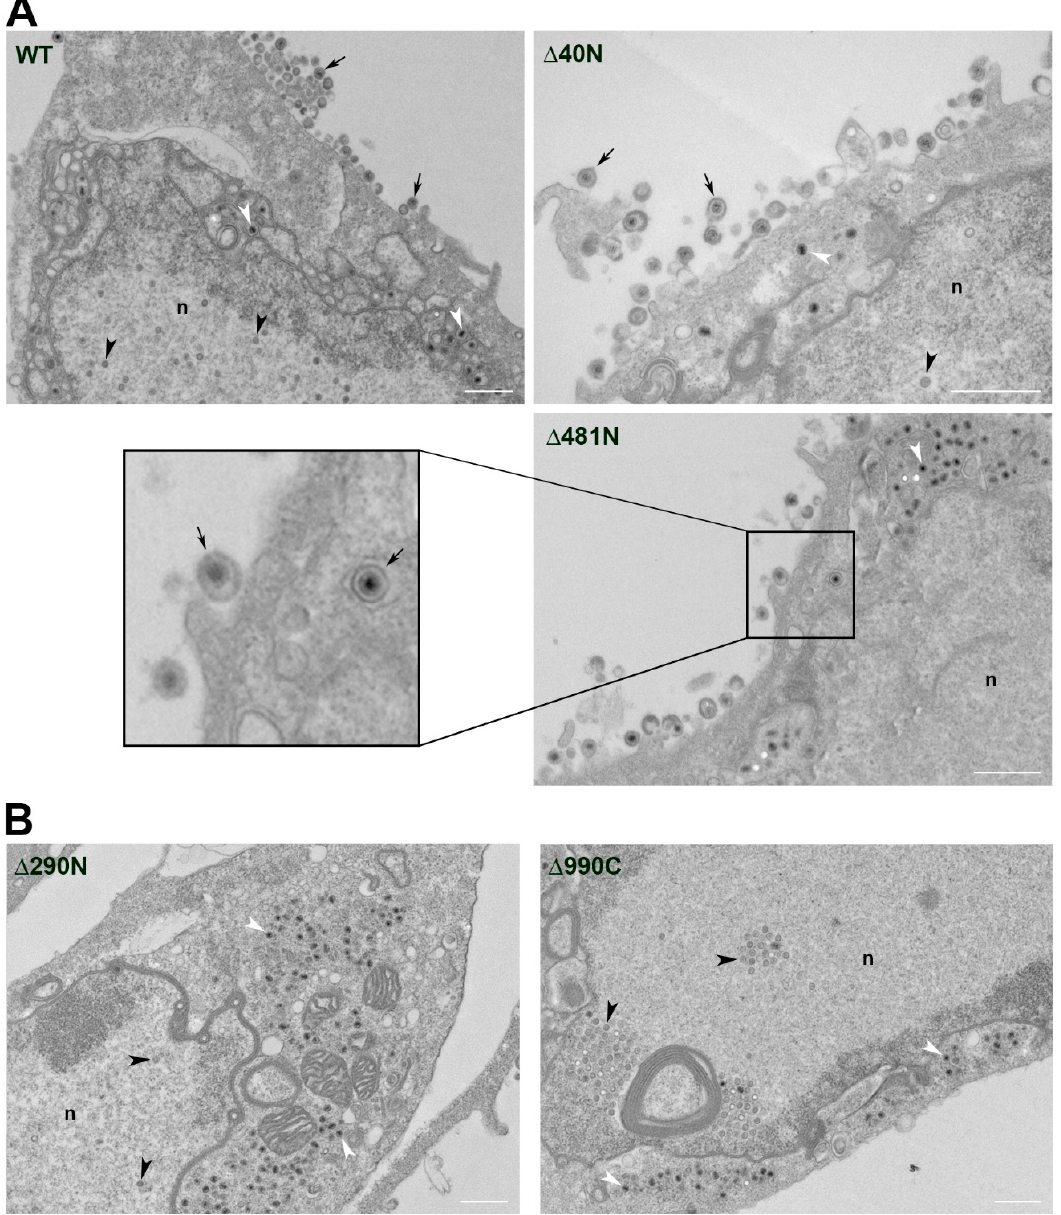
Figure 3. The pUL37 polypeptide sequence 481–1123 supports secondary envelopment of virus particles. Vero cells were infected with each UL37-mutant virus and analyzed by TEM at 18 h post-infection. ( A ) Particles representing normal virion morphogenesis were observed in cells infected with viruses expressing wild-type (WT), Δ 40N, and Δ 481N pUL37–EGFP. These include capsids in the nucleus (n) (black arrowheads), electron-dense DNA-filled capsids in the cytoplasm (white arrowheads), and enveloped virus particles in the cytoplasm and exiting the cell (arrows). ( B ) Cells shown were infected Δ 290N or Δ 990C pUL37–EGFP expressing viruses. Enveloped DNA-filled capsids were not observed in the cytoplasm or at the cell surface. Images are representative of all viruses which failed to produce secondary enveloped virus particles. Scale bar = 1 µm.